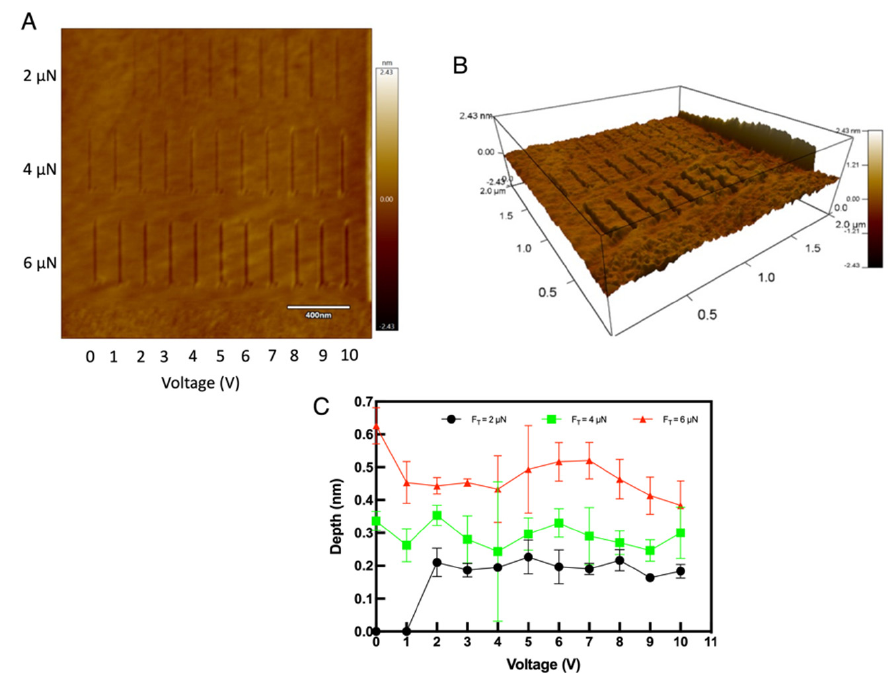
Figure 9. Scratching tests on HF treated silicon: ( A ) The etched lines on the silicon surface with different forces and voltages ( B ) The 3D image of the same where the etched depth can be seen clearly increasing with higher force ( C ) The depth vas voltage graph showing the influence of different tip force.